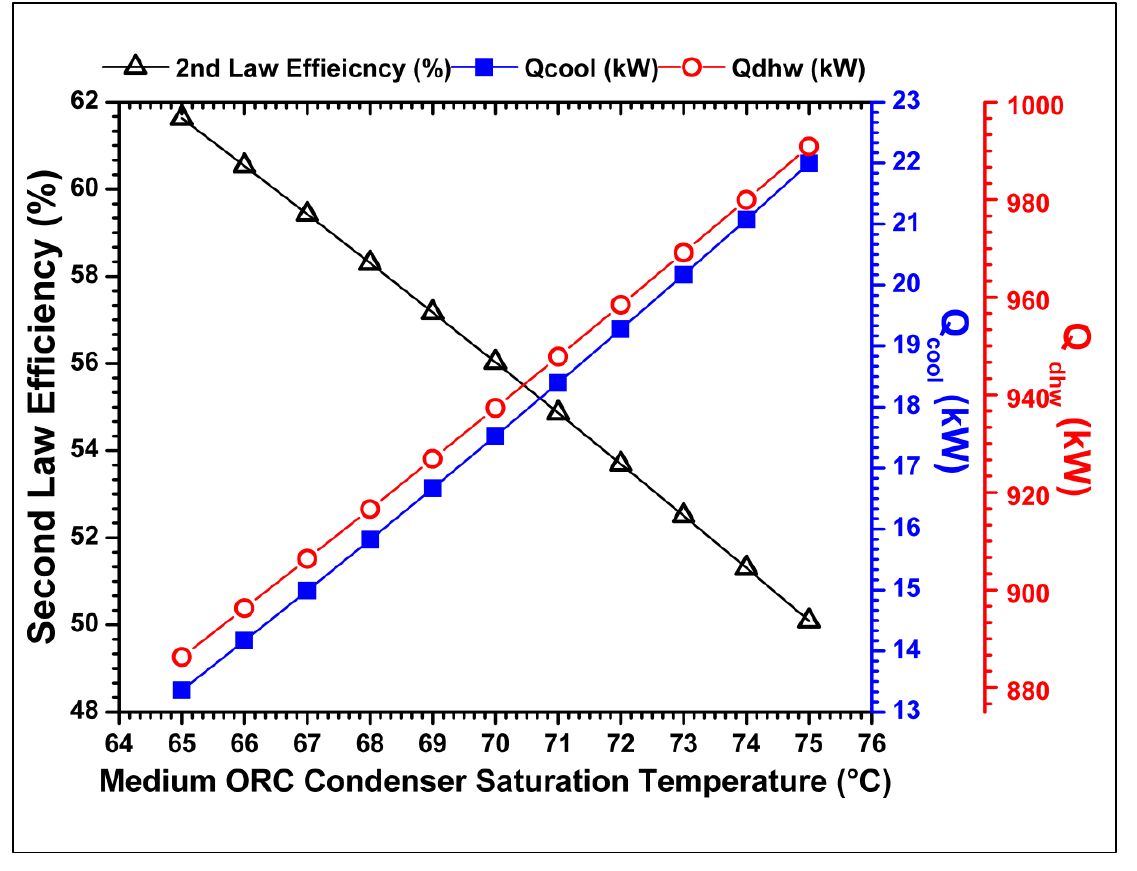
Figure 8. The variation of the cooling, heating, and second law efficiency against the saturation condensation temperature of the medium temperature heat source powered ORC.